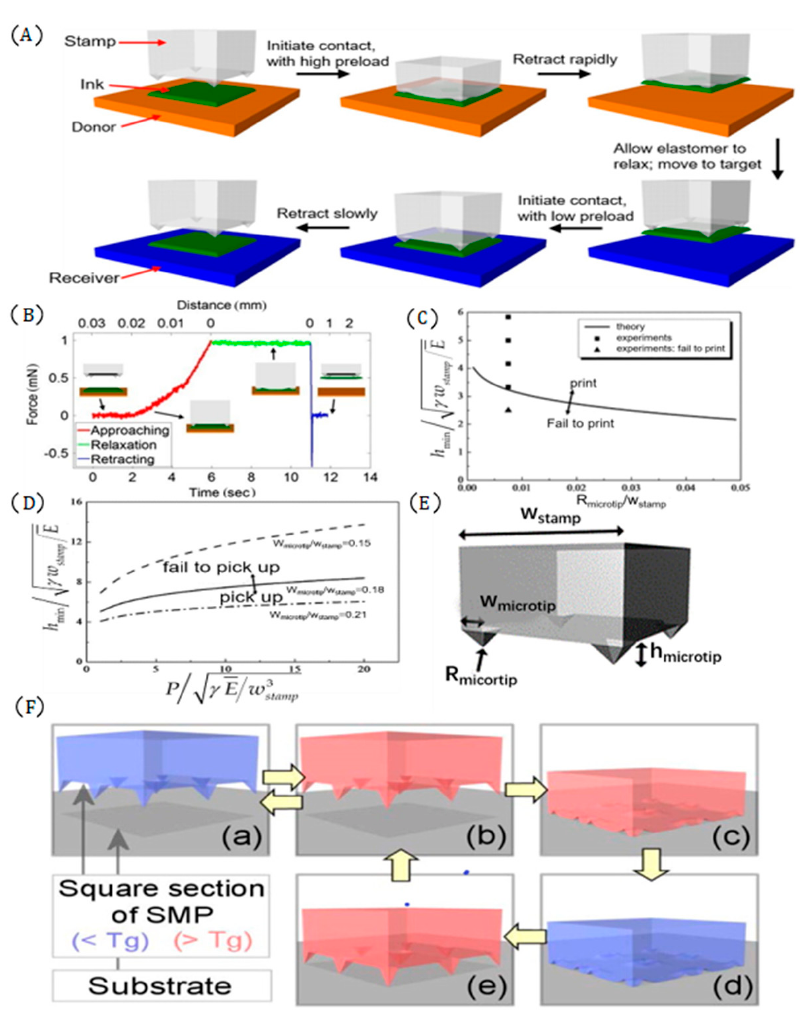
Figure 10. Assist transfer printing technology of the seal with a pyramid microstructure. ( A ) Transfer printing diagram with a pyramid structure seal (PDMS) (reproduced from [61]), ( B ) time graph of force in complete mechanical collapse at a retraction speed of 1 mm/s under a preload of 1 mN (reproduced from [61]), ( C ) the relationship between the height of the pyramid and the contact radius at the top of the pyramid (reproduced from [60]), ( D ) pyramid height and preload relationship diagram (reproduced from [60]), ( E ) seal size parameter diagram (reproduced from [60]), and ( F ) transfer diagram with a pyramid structure seal (SMP) (reproduced from [82]), The blue seal indicates that the seal is in a rigid state, and the red seal indicates that the seal is in a flexible state.